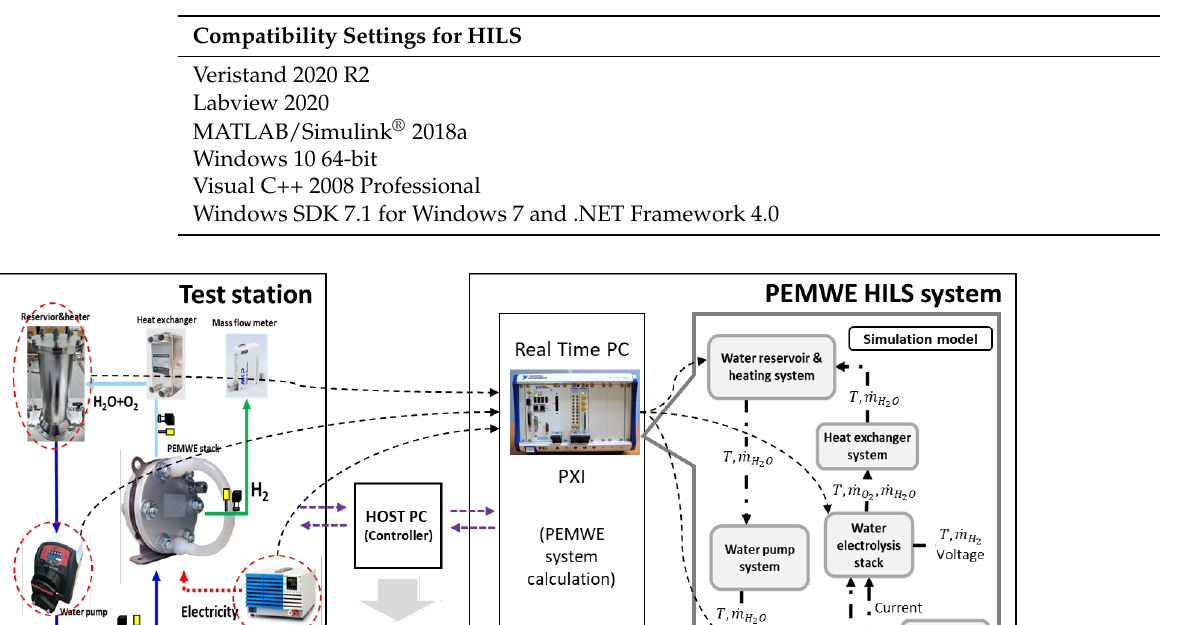
Table 2. Compatibility settings for HILS.